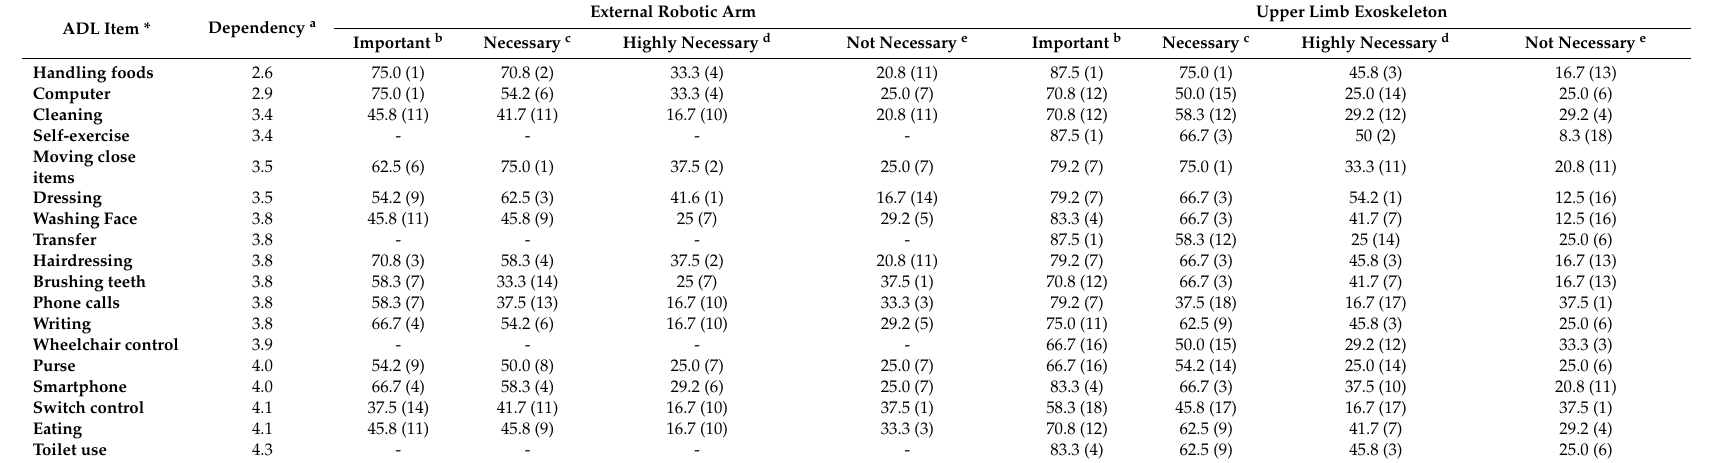
Table 2. Dependency, importance, and necessity for assistive robots in the unilateral impairment group ( n =